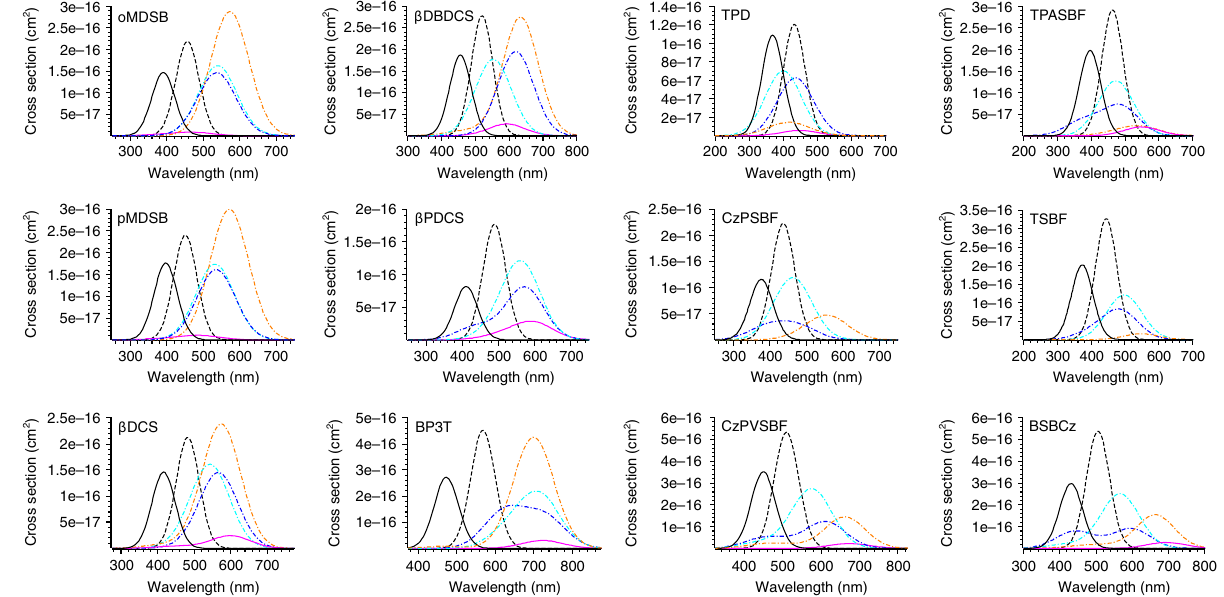
Fig. 5 Theoretically predicted S 1 emission cross sections and various absorption cross sections. Black solid line and black dashed line denote the self- absorption cross section and stimulated emission cross section of S 1 , respectively. Various absorption cross sections (if any) introduced by S 1 → S n ! D þ ! D (cid:1) (magenta solid), T 1 → T n (orange dot-dashed), D þ (blue dot-dashed), and D (cid:1) (cyan dot-dashed) are shown in the vicinity of the emission 0 n 0 n wavelength (±125 nm). Losses under optical pumping are indicated by solid lines, which are not signi fi cant for all candidates, while losses under electrical pumping are indicated by both solid and dot-dashed lines. Most candidates suffer from losses introduced by triplet excitons and polarons as indicated by þ (cid:1) ! D þ n ! D (cid:1) n the value of σ T 1 ! T n , σ D , and σ D at the emission wavelength, while such losses are moderate compared to the large stimulated emission cross 0 0 abs abs abs section of S 1 for BP3T, CzPVSBF, and